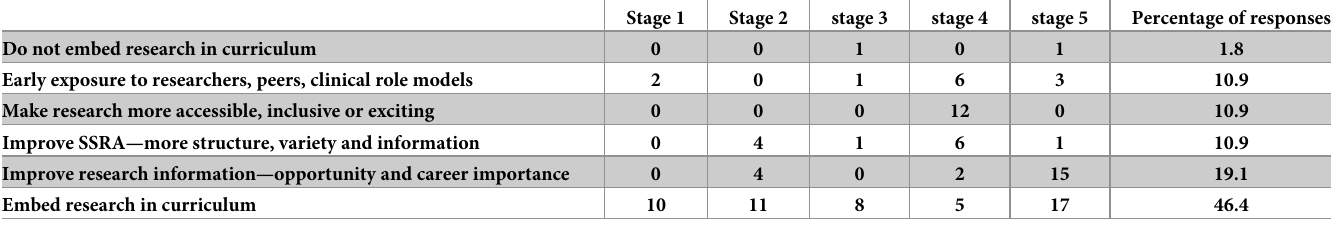
Table 2. Recommendations for improving research-teaching